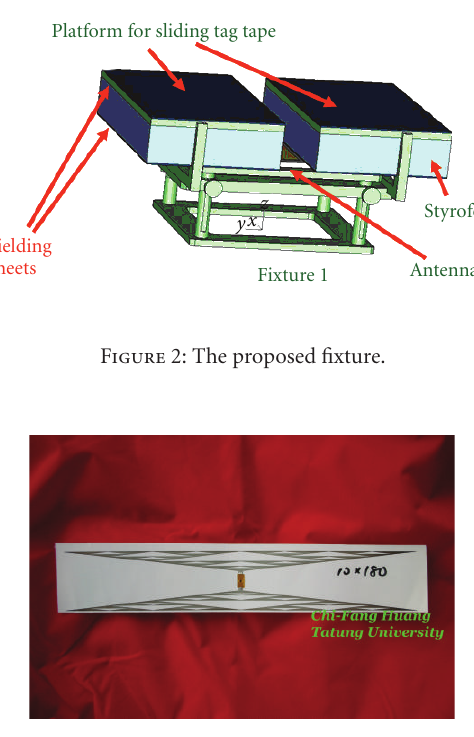
Figure 3: An RFID tag printed on a paper substrate [4].